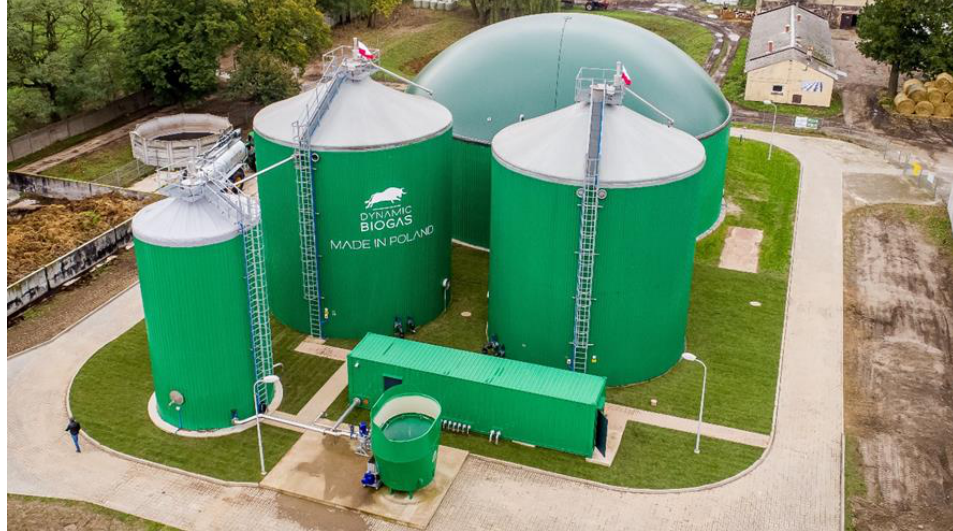
Figure 2. 500 kW biogas plant at Przybroda PULS experimental farm.